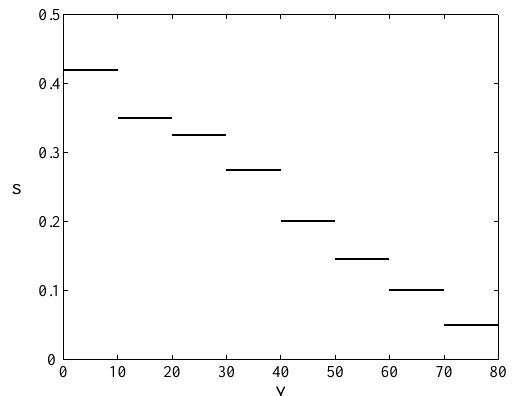
Fig. 2. Rank-ordered multifractal spectrum for a (1024 × 1024) 2-D MHD simulation, s(Y) , Y = and δ in grid spacing. The spectrum is calculated for 8 contiguous ranges of 1Y .